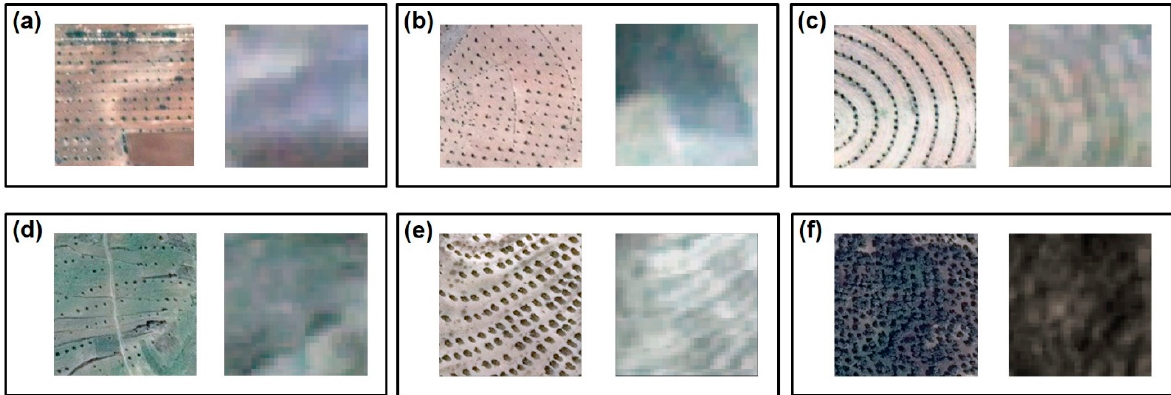
Figure 5. The difference in olive orchards with DG (left) and Planet imagery (right). ( a – c ) are from the semi-arid region, ( d – f ) are from the sub-humid region. ( a , b ) show areas where olives are visible on DG imagery but not on Planet imagery due to small crown sizes; ( c ) shows the case where olives are visible both on DG imagery and on Planet imagery; ( d ) shows the case where olives are visible on DG imagery, but not on Planet imagery due to small crown sizes; ( e ) shows the case where olives are visible both on DG imagery and on Planet imagery; ( f ) shows the case where non-olive vegetation shows similar features as olives on Planet imagery.